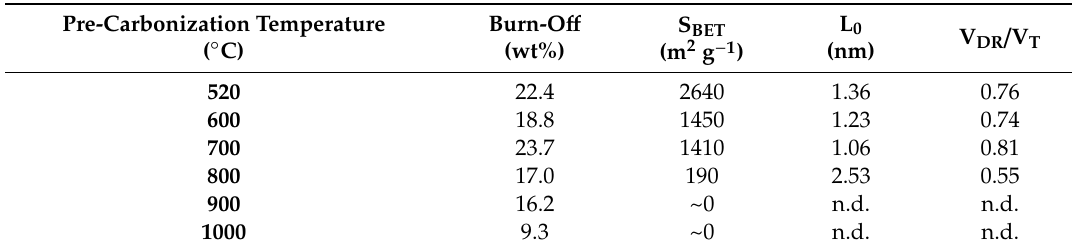
Table 6. Porosity parameters of ACs produced by KOH activation of pitch-derived cokes (coke/KOH ratio 1:3, reaction temperature 800 °C, soaking 1 h).